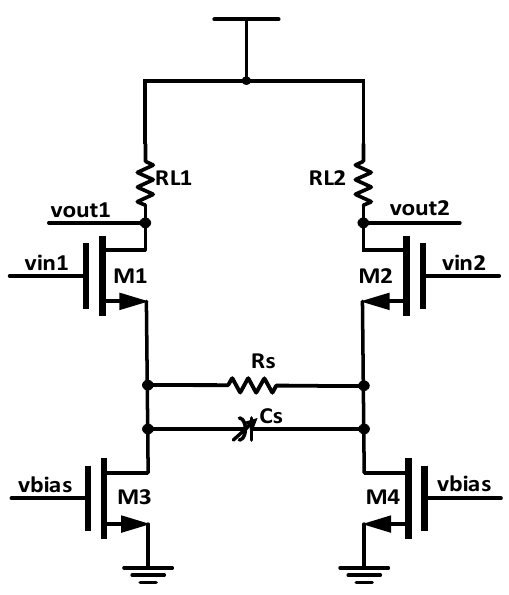
Figure 2. Schematic of Conventional CTLE.